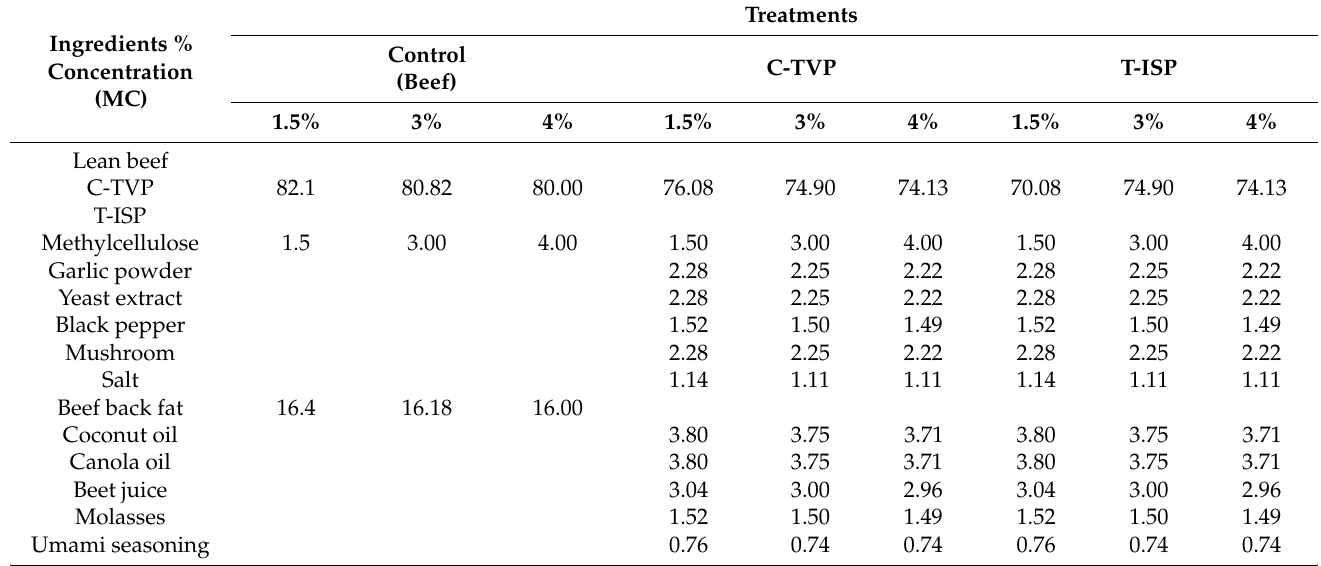
Table 1. Treatment and formulation of plant-based meat